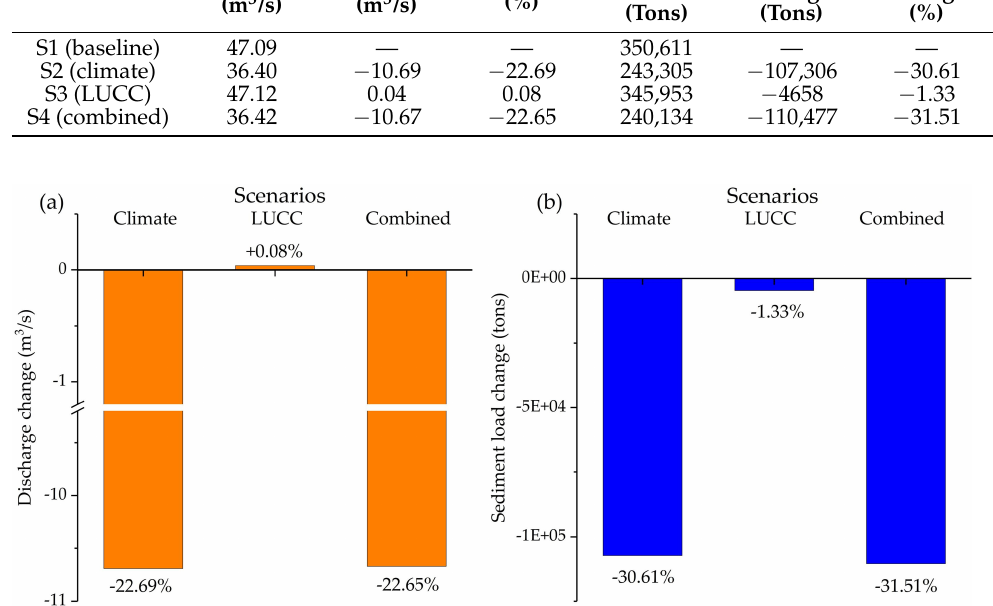
Figure 4. The variations of discharge and sediment load under different scenarios: ( a ) discharge variations; ( b ) sediment load